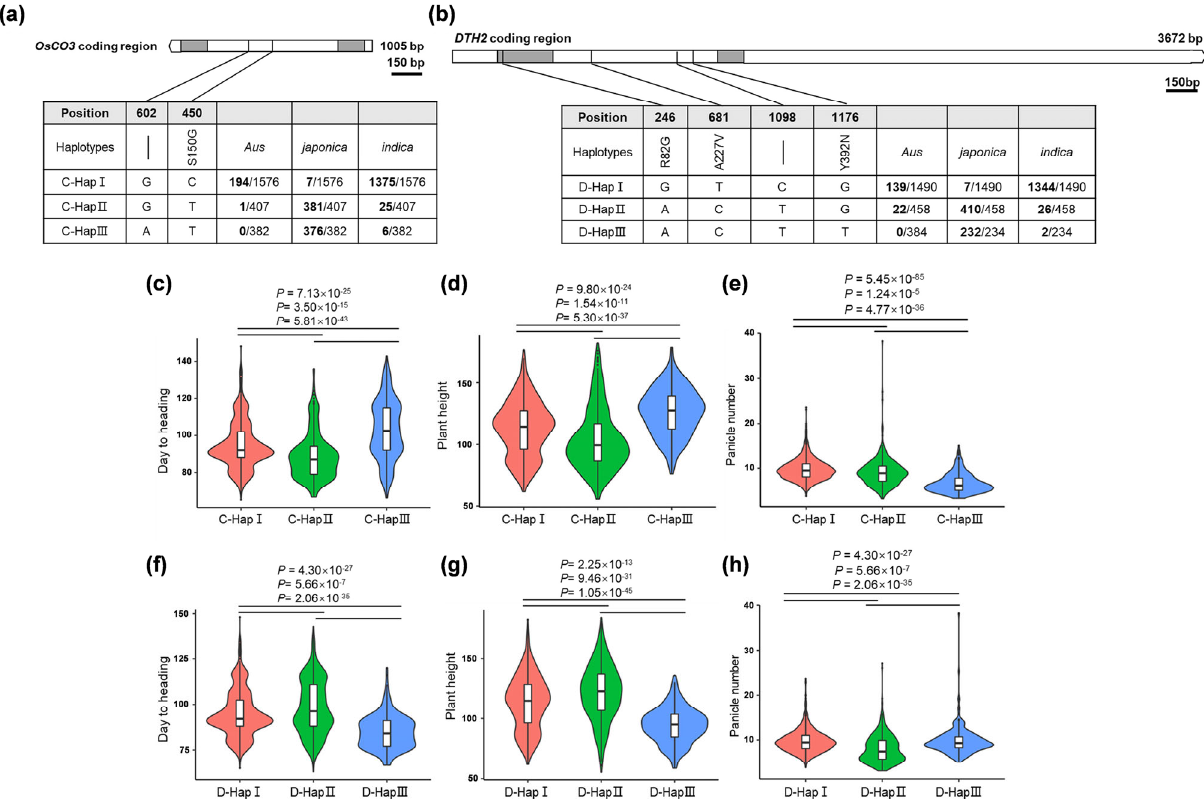
Figure 4. Haplotypes of OsCO3 and DTH2 in rice and their association with agronomic traits. ( a ) and ( b ) Haplotypes of OsCO3 and DTH2 and their distributions in indica , japonica , and Aus varieties. ( c – e ) The association between the haplotypes of OsCO3 and days to heading, plant height, and panicle number. ( f – h ) The association between the haplotypes of DTH2 and days to heading, plant height, and panicle number. The haplotype and agronomic trait data were retrieved on RFGB v2.0 (https://www.rmbreeding.cn/, accessed on 11 November 2022) and RiceVarMap v2.0 (http://ricevarmap.ncpgr.cn/, accessed on 11 November 2022).